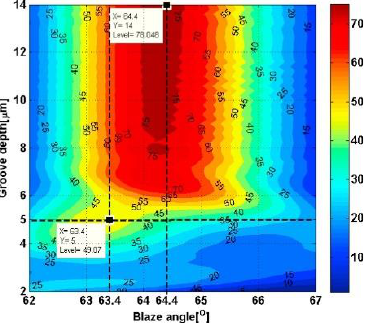
Figure 4. Diffraction efficiency versus grating structure size [35].